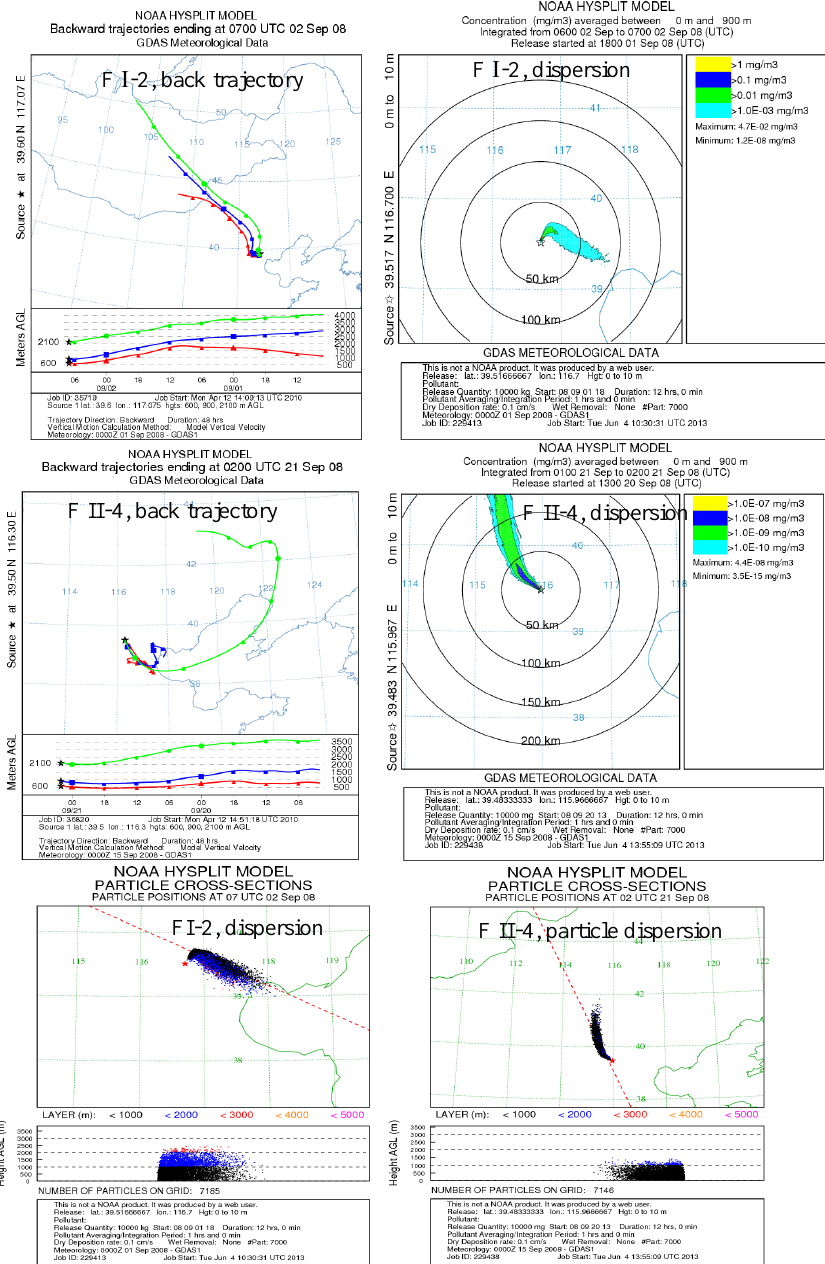
Fig. 4 A 48 h back trajectories and 12 h forecast dispersions for FΙ-2 and FII-4 of Fig. 4. 48h back trajectories and 12h forecast dispersions for flights FI-2 and FII-4 of G2.